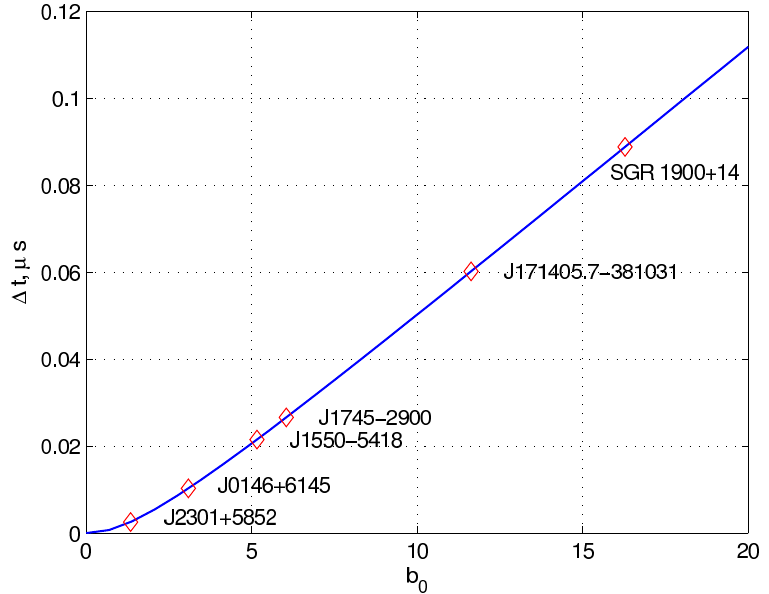
Figure 3 . Time delay between